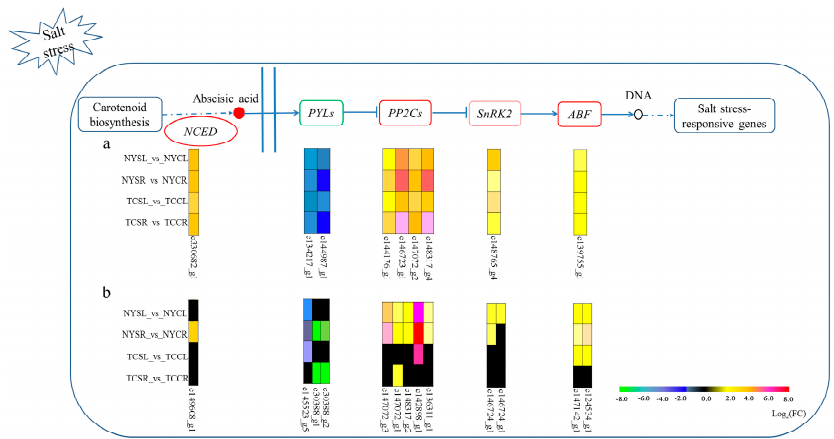
Figure 5. PYL-ABA-PP2C pathway in plant hormone signal transduction. ( a ) Expression profile of nine common DEGs across both tissues and genotypes; ( b ) Expression profile of twelve DEGs in NY leaves, NY roots, TC leaves, or TC roots. NYSL (NY salt-stressed leaf); NYCL (NY control leaf); NYSR